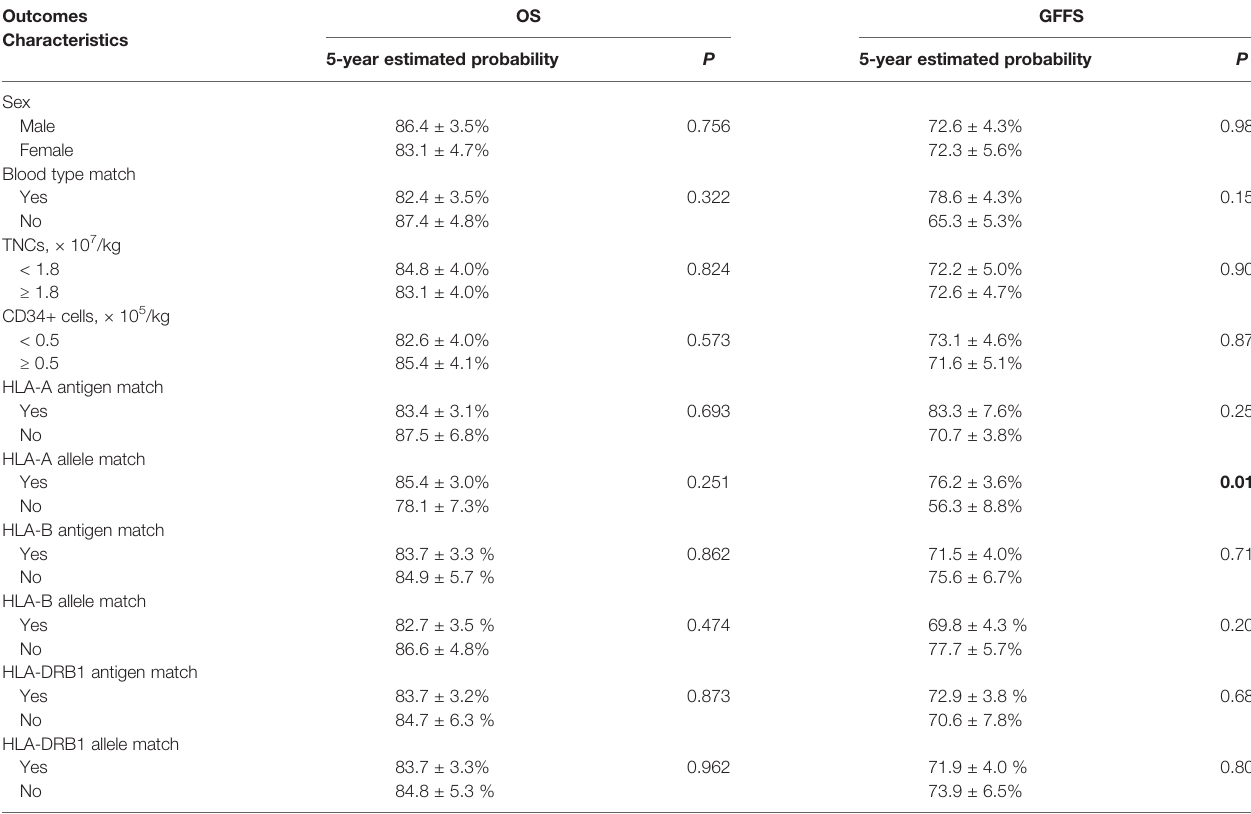
TABLE 4 | Univariate analysis of UCB-related characteristics on OS and GFFS. Outcomes